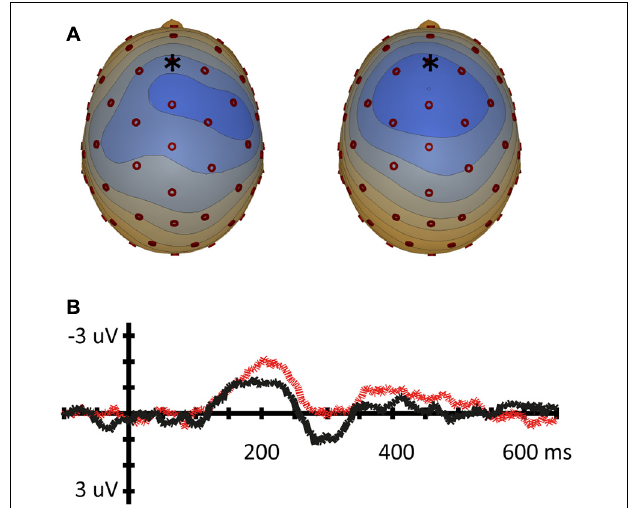
FIGURE 6 | Mismatch negativity for the two-feature contrast (vowel pair /e-o/). (A) Topographic voltage plots of the MMN at the average MMN peak latency for both conditions (left: [e]/o/, 203 ms; right [o]/e/, 212 ms). Blue in topoplot indicates negative potential ( µ V), red indicates positive potential, electrode Fz is indicated with an asterisk. (B) MMN waveforms for the Fz electrode [e]/o/ (black solid line) and [o]/e/ (red dashed).